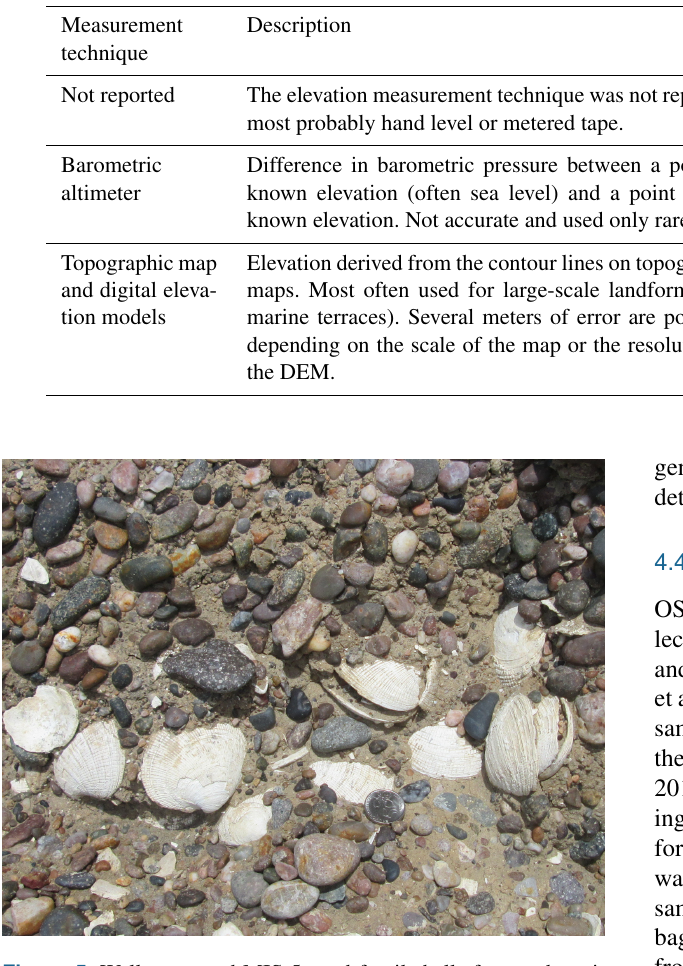
Figure 5. Well-preserved MIS 5-aged fossil shells from a deposit near Caleta Olivia. The coin is 23mm in